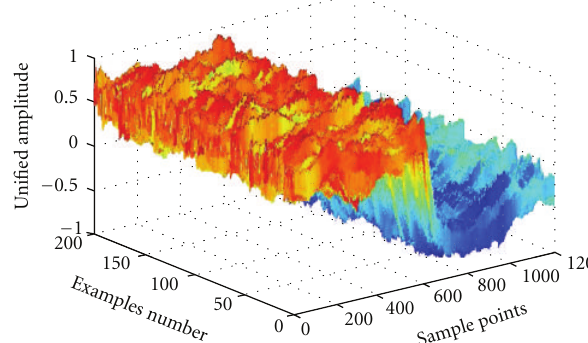
Figure 7: Mesh patterns of 200 examples for generation